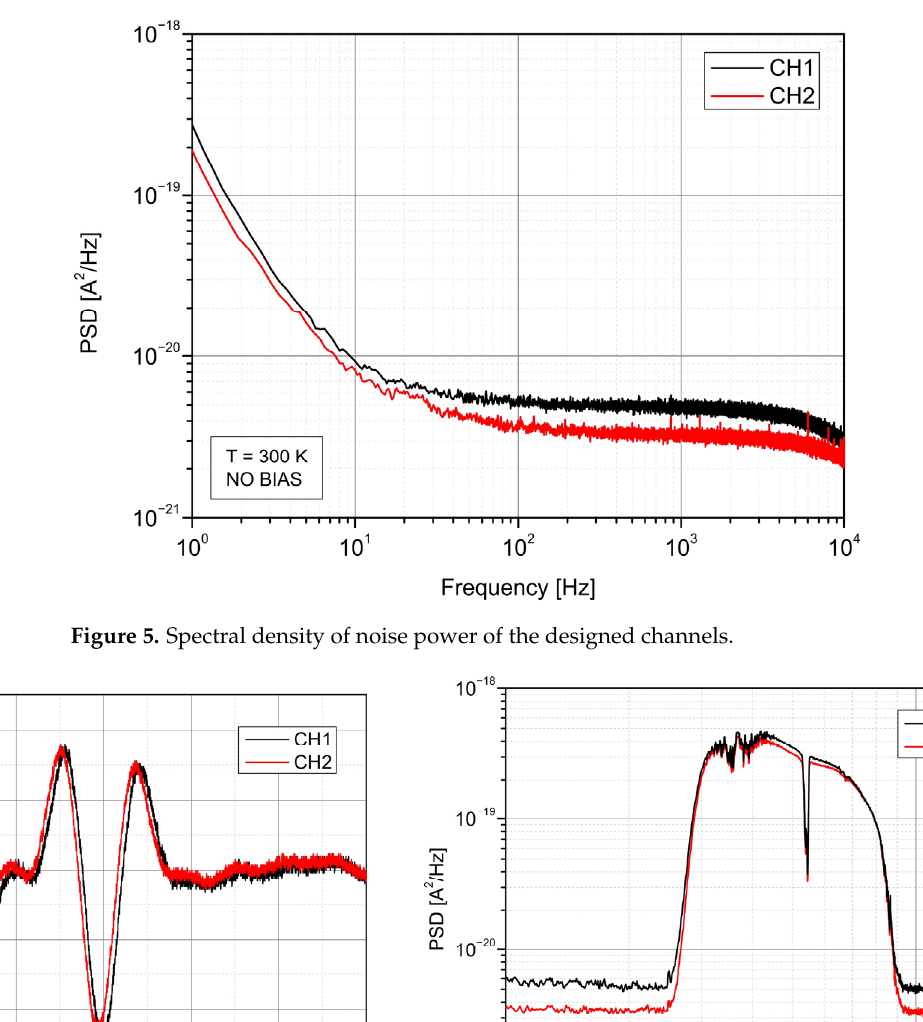
Figure 5. Spectral density of noise power of the designed channels.